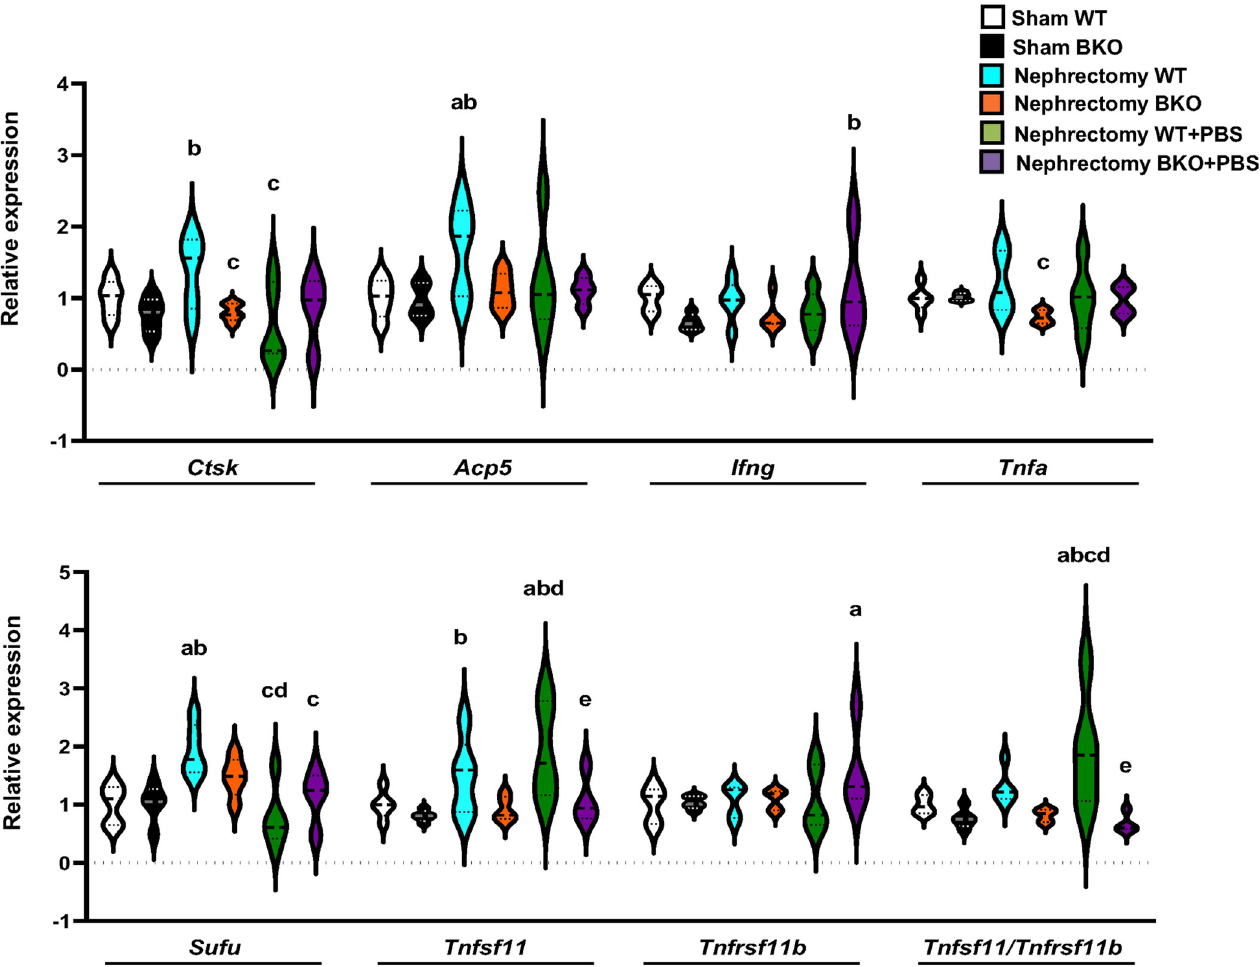
Fig 7. Nephrectomy in WT with or without PBS exposure upregulates osteoclast-related gene expression in femurs. Violin plots for qPCR analysis of osteoclast-related genes (n = 4–5 per group). a p < 0.05 versus sham WT, b p < 0.05 versus sham BKO, c p < 0.05 versus nephrectomized WT, d p < 0.05 versus nephrectomized BKO, and e p < 0.05 versus nephrectomized WT+PBS.